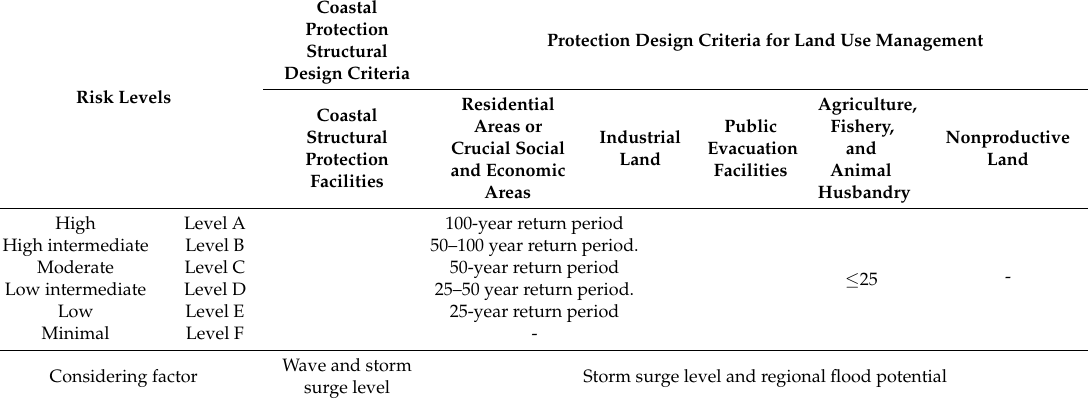
Table 3. Grading of risk levels and coastal protection design